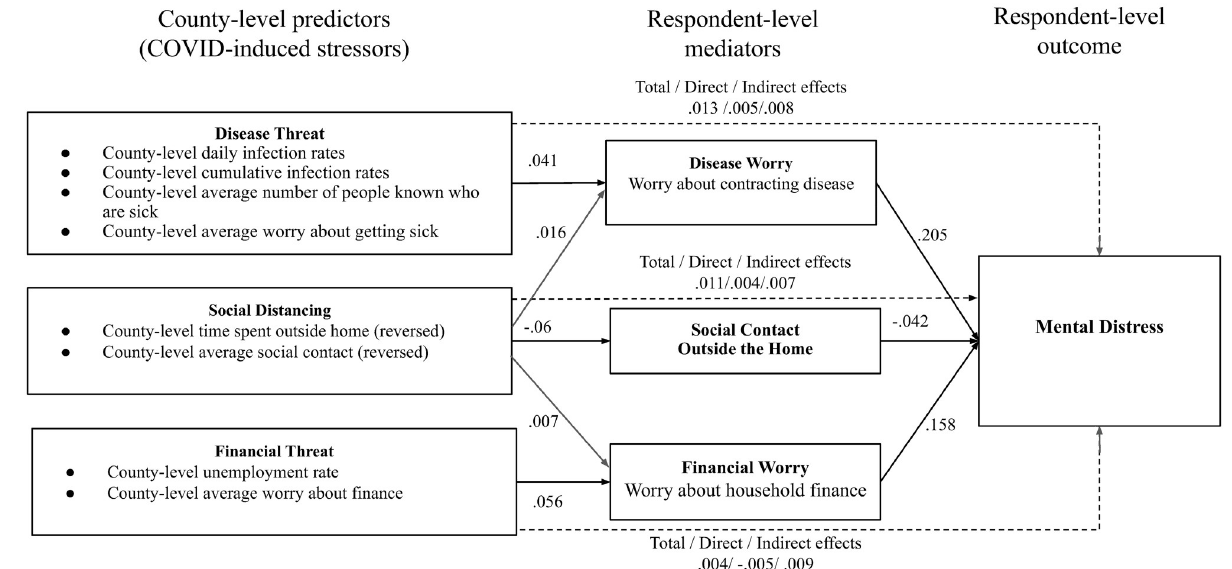
Fig 3. Path diagram showing the direct and indirect effects of county-level stressors on respondents’ mental